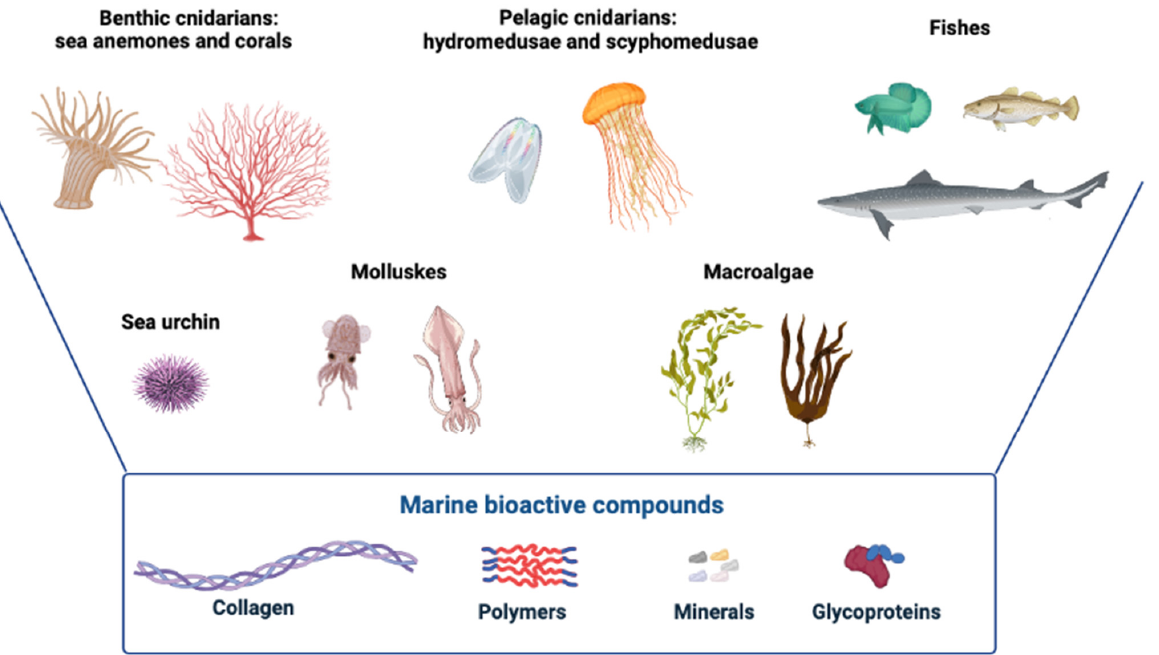
Figure 3. Main sources of marine bioactive compounds (collagen, polymers, minerals, and glycoproteins): cnidarians, fish, molluskes and, microalgae. Created with BioRender.com.